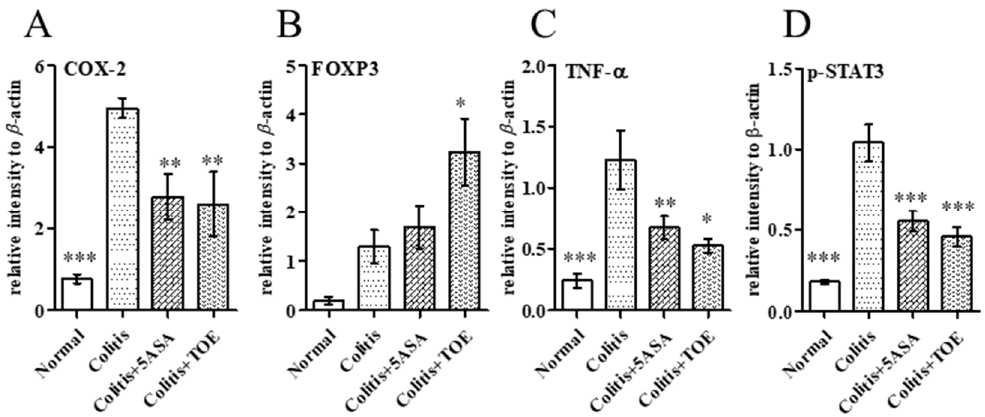
Figure 8. Relative intensity of protein expression levels in chronic colitis tissues of C57BL / 6 mice determined using western blotting. ( A ) Cyclooxygenase-2 (COX-2), ( B ) forkhead box P3 (FOXP3), ( C ) tumor necrosis factor alpha (TNF- α ), ( D ) phosphorylated signal transducer and activator of transcription-3 (p-STAT3). * p < 0.05, ** p < 0.01, *** p < 0.001, compared with the colitis group. Normal, DSS- / D.W; colitis, DSS + / D.W, colitis + 5-ASA, DSS + / 5-ASA 50 mg per kg; colitis + TOE, DSS + / TOE 15 mg per